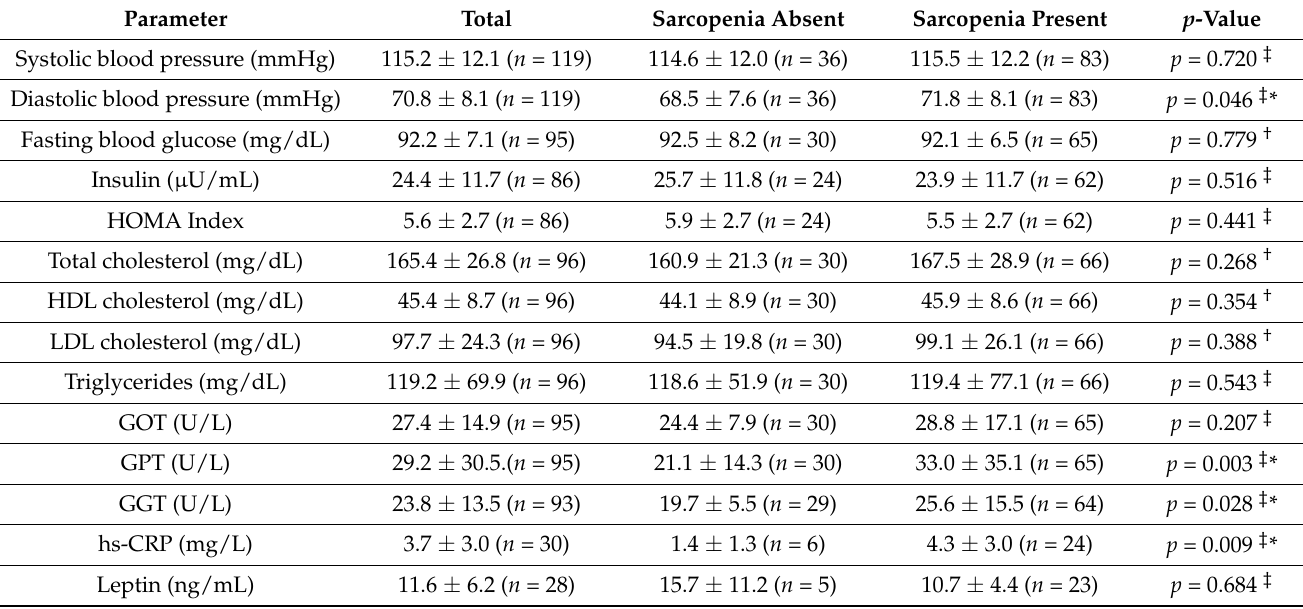
Table 2. Blood pressure and laboratory parameters of the whole group and by the presence of sarcopenia.